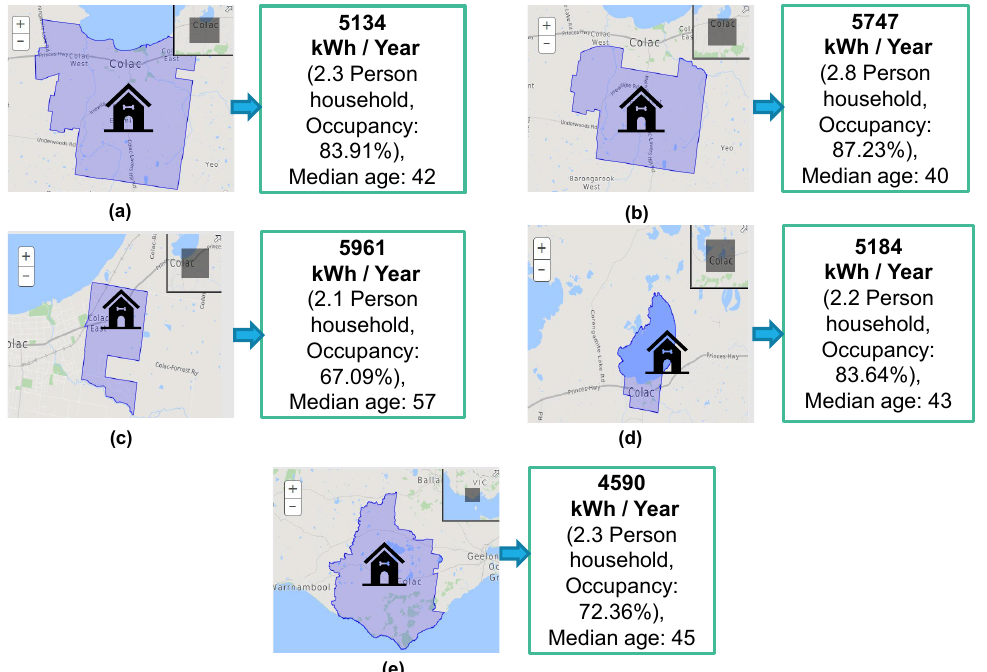
Figure 3. Variations in household energy usage among different demographic regions ( a ) Colac SA2, ( b ) Colac Elliminyt, ( c ) Colac East, ( d ) Colac State Suburbs, ( e ) Colac